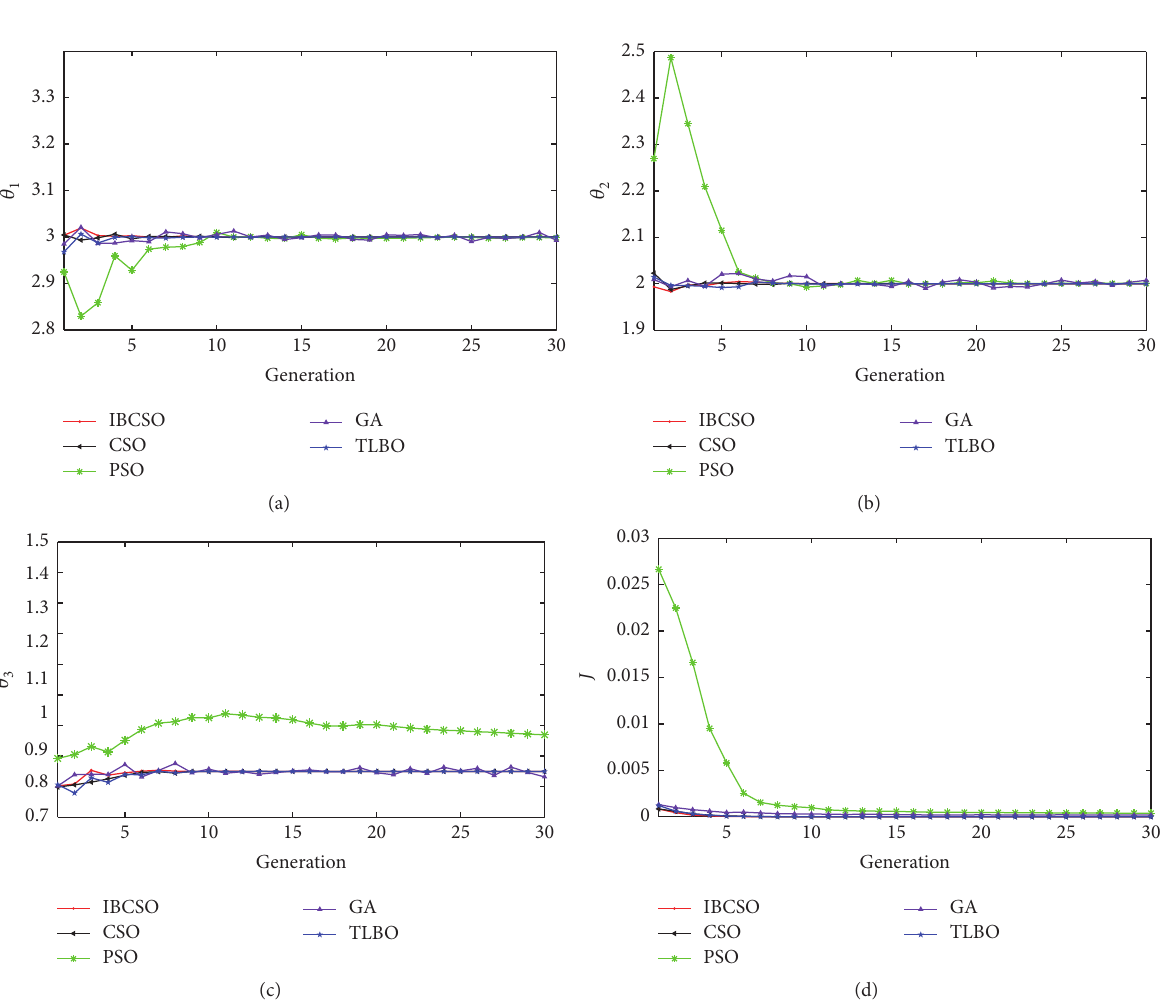
Figure 5: The evolving process of the average values obtained by IBCSO, CSO, PSO, GA, and TLBO in offline mode. (a) 𝜃 1 ; (b) 𝜃 2 ; (c) 𝜃 3 ; (d)